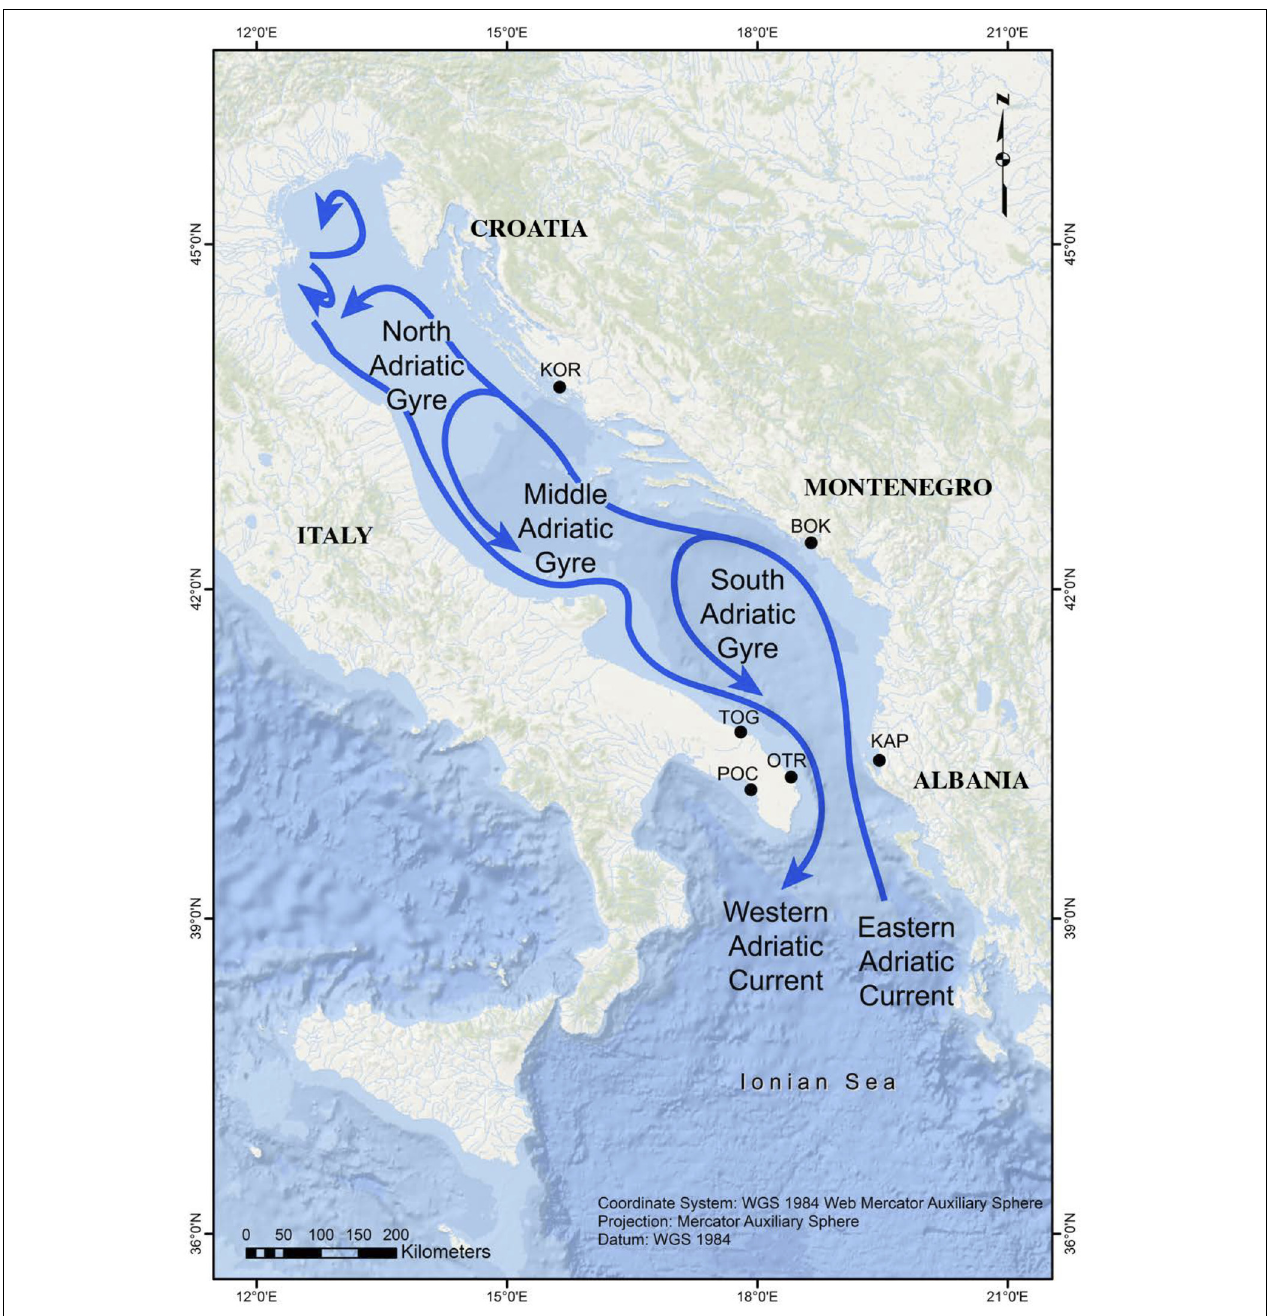
FIGURE 1 | Map showing the sampling locations in the Adriatic Sea and its main surface currents (adapted from Melià et al., 2016).